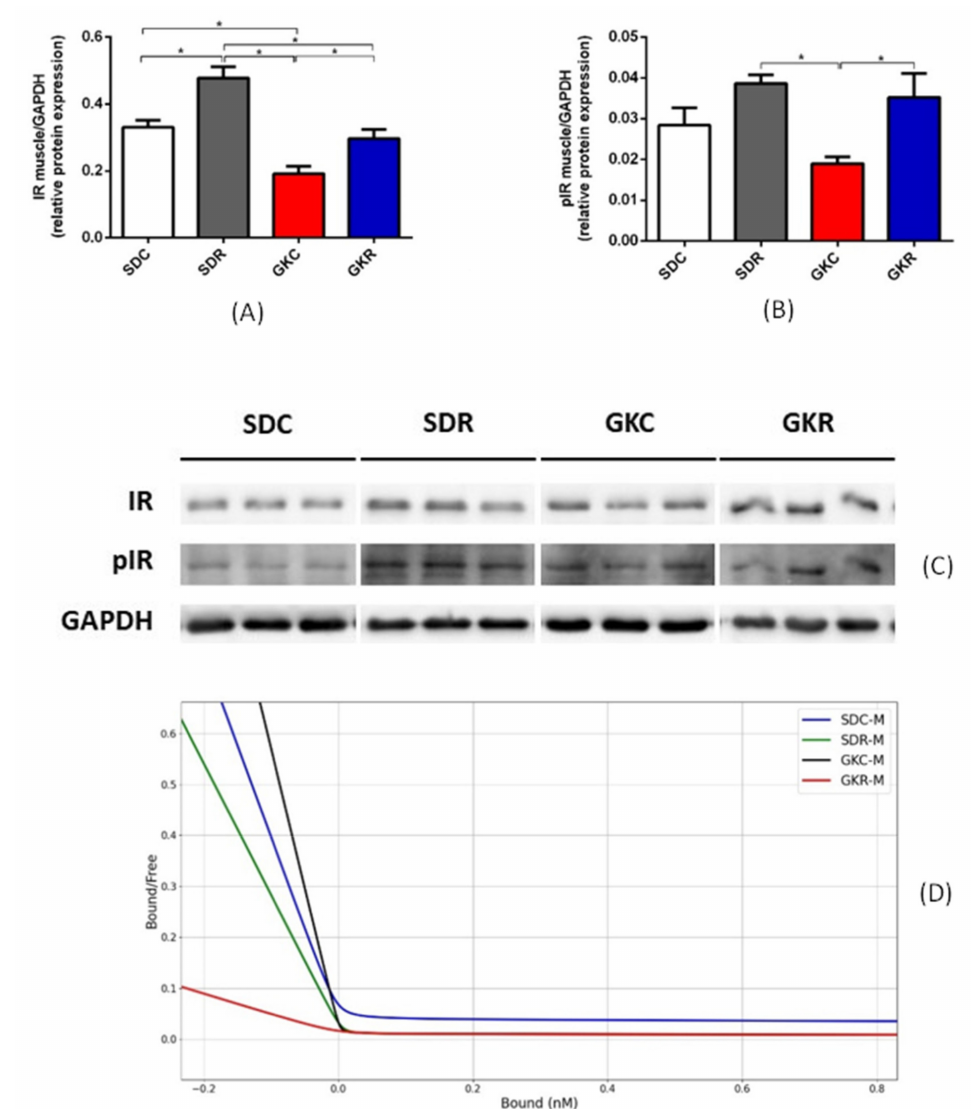
Figure 2. Effects of resveratrol on expression and phosphorylation of insulin receptor and on insulin binding in the skeletal muscle of SD and GK rats. Expression of insulin receptor ( A ), phosphorylation of insulin receptor ( B ), Western blot immunodetection with antibodies to the indicated proteins, GAPDH expression used as a loading control. Protein levels relative to GAPDH quantified by densitometry. Results are representative of at least two independent experiments ( C ), Scatchard plot showing insulin binding to insulin receptor ( D ). Bound—insulin bound to insulin receptor, Free—free insulin. SDC—Sprague-Dawley control rats, SDR—Sprague-Dawley rats treated with resveratrol, GKC—Goto-Kakizaki control rats, GKR—Goto-Kakizaki rats treated with resveratrol. Results represent the means ± SEM from 10 rats. In the case of studies concerning insulin binding, tissues from 2–3 rats were pooled and results were expressed as the means ± SEM from 4 separate determinations *—Differences statistically significant ( p <